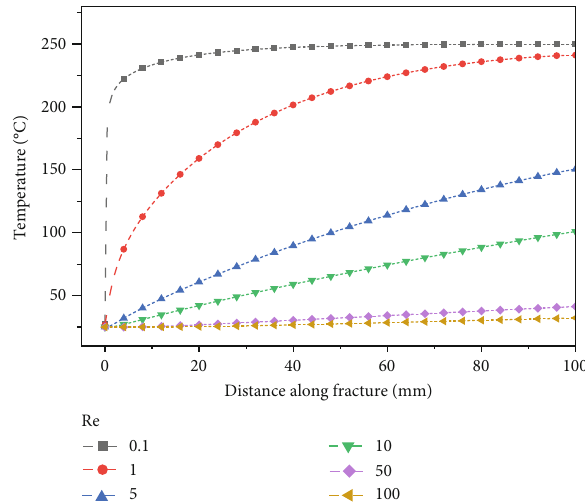
Figure 6: Temperature distribution of fl uid along fracture.